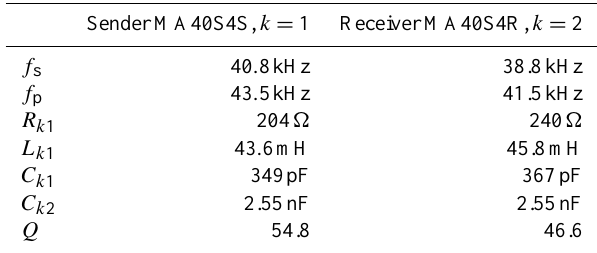
Table 1. Measured and calculated values of the transceiver Murata MA40S4S and